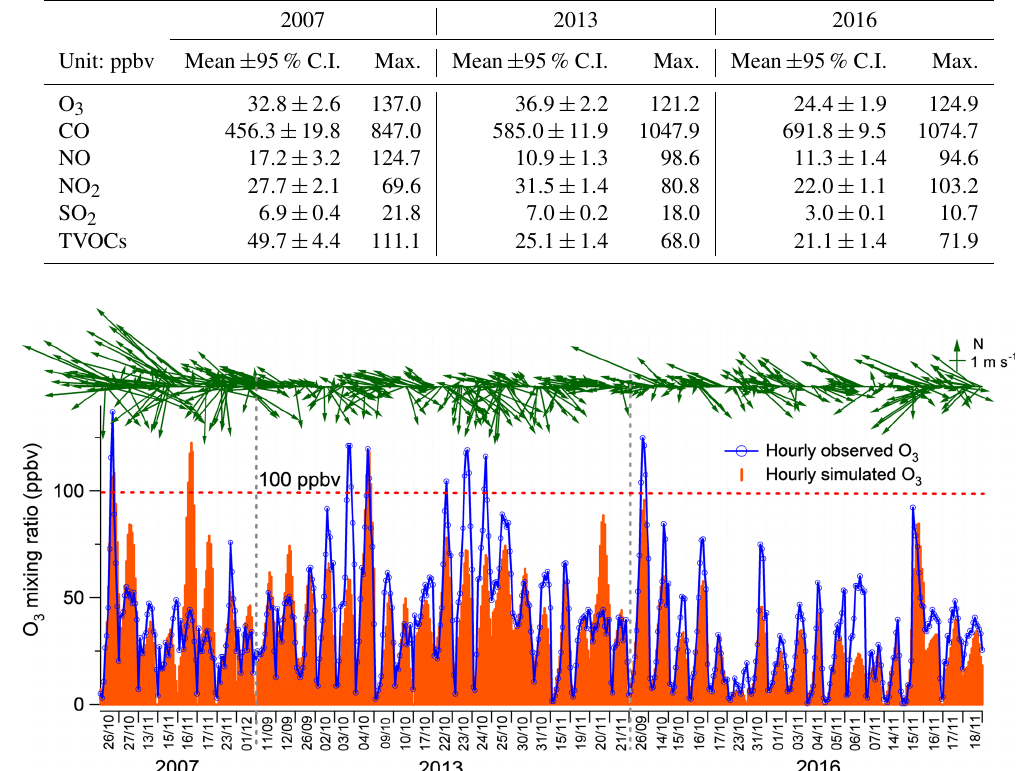
Table 1. Mixing ratios of the measured trace gases and TVOCs averaged on the selective 45 VOC sampling days in 2007, 2013 and 2016.